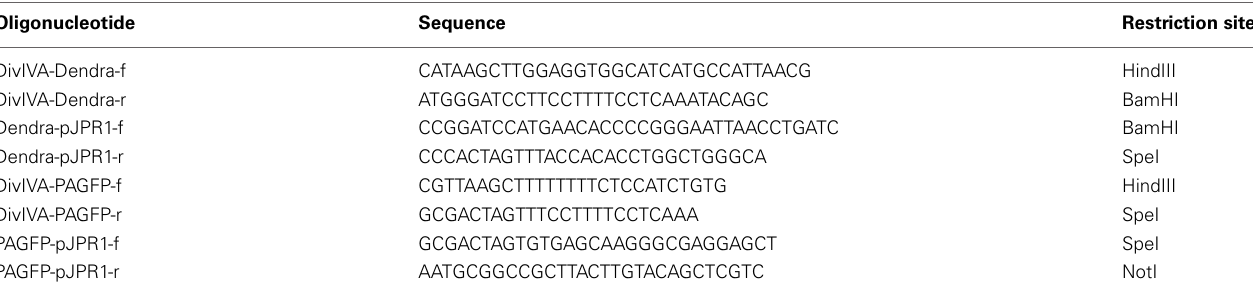
Table 1 | Oligonucleotides used in this study. Oligonucleotide